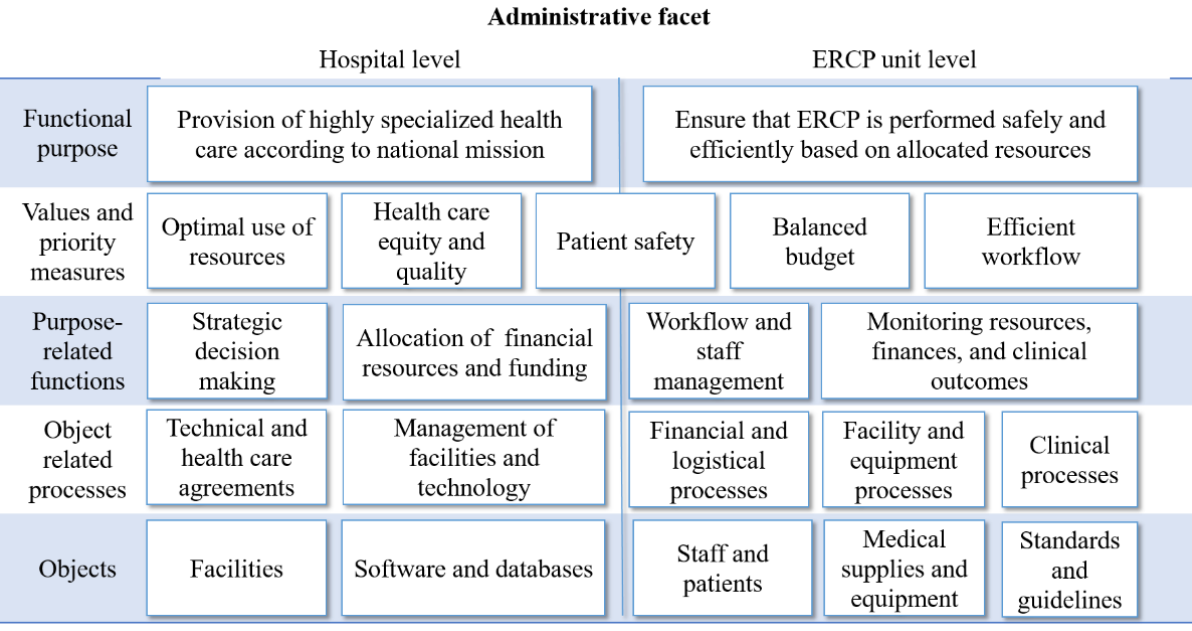
Figure 5. Abstraction hierarchy, administrative